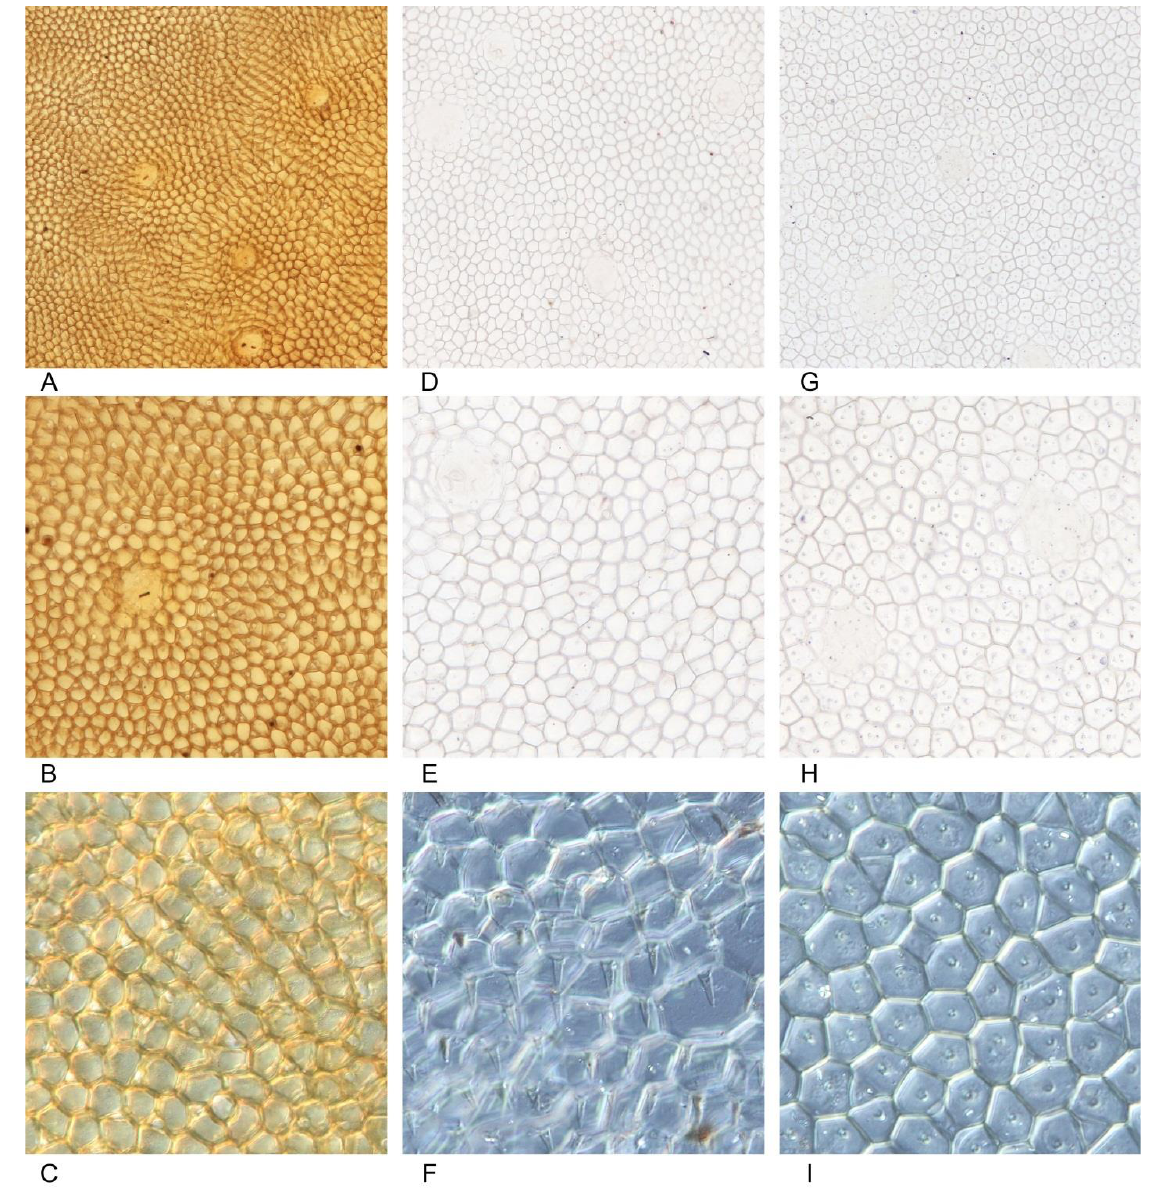
Figure 8. Platerodrilus svetae , cuticle. ( A ) — female larva, ×150 magnification; ( B ) — female larva, ×300 magnification; ( C ) — female larva, DIC, ×600 magnification; ( D ) — female, outer cuticle, ×150 magnification; ( E ) — female, outer cuticle, ×300 magnification; ( F ) — female, outer cuticle, DIC, ×600 magnification; ( G ) — female, inner cuticle, ×150 magnification; ( H ) — female, inner cuticle, ×300 magnification; ( I ) — female, inner cuticle, DIC, ×600 magnification.